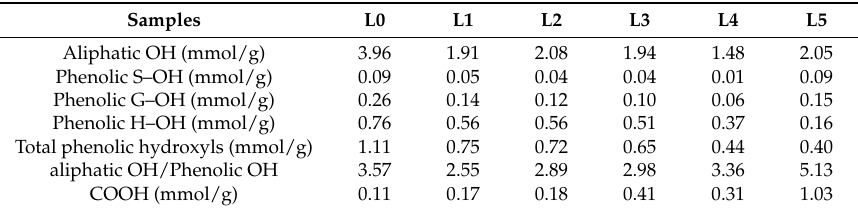
Table 3. The content of hydroxyl groups in lignin samples